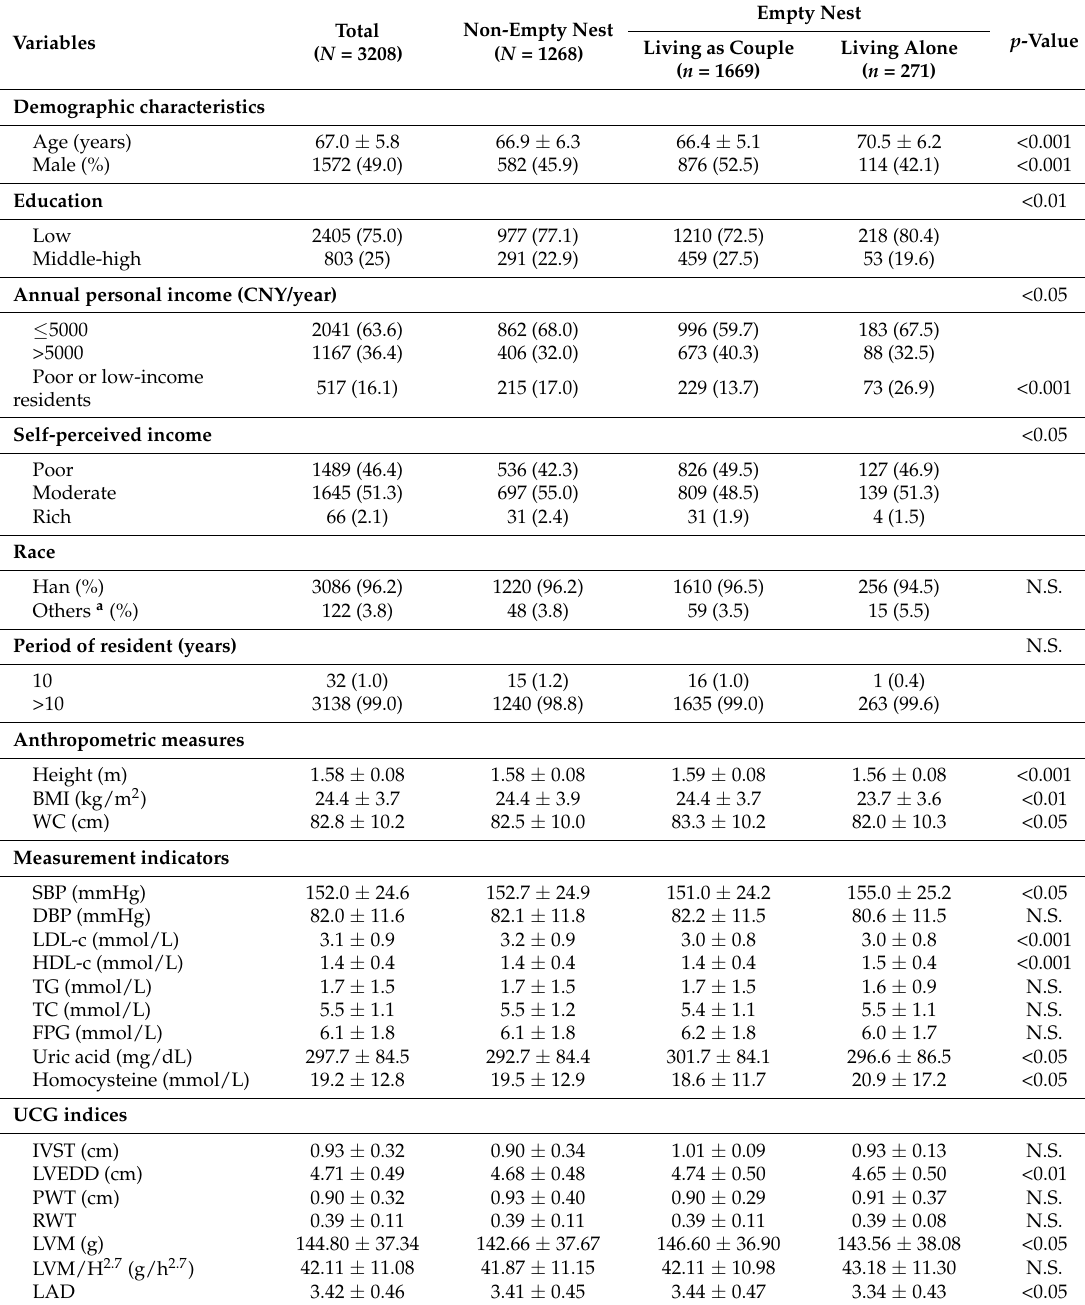
Table 1. Baseline characteristics of study